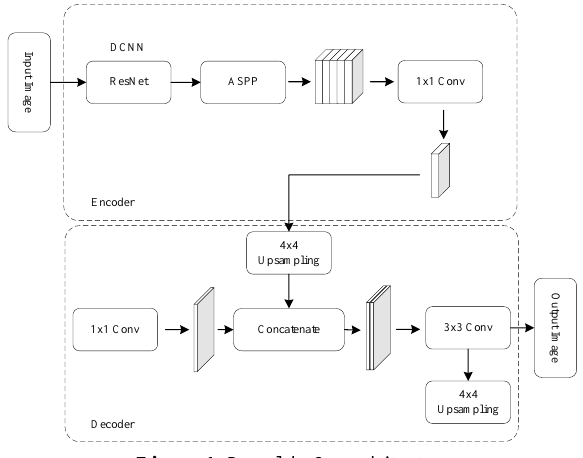
Figure 1 . Deeplabv3+ architecture